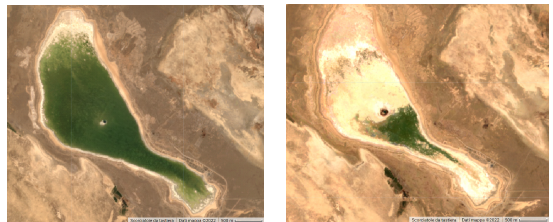
Figure 10. Sentinel-2 median image of Sawa lake on January-March 2020 (left) and on January-March 2022 (right).